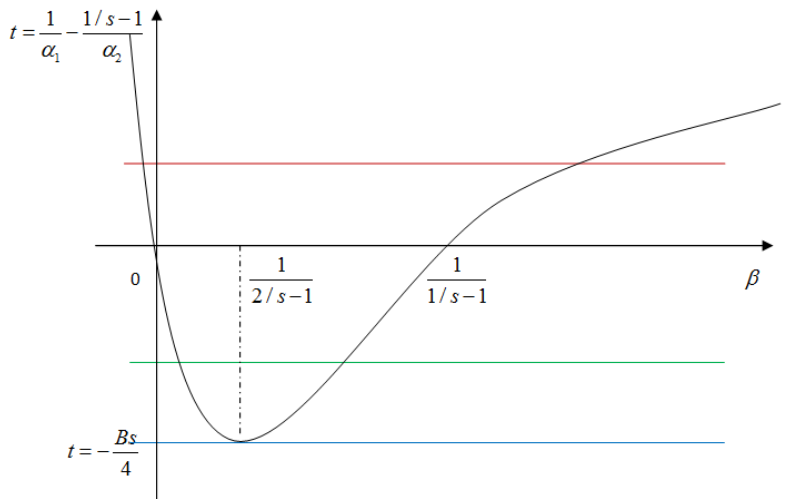
Figure A1. Su ffi cient condition of Corollary Figure 4. Sufficient condition of Corollary 5.